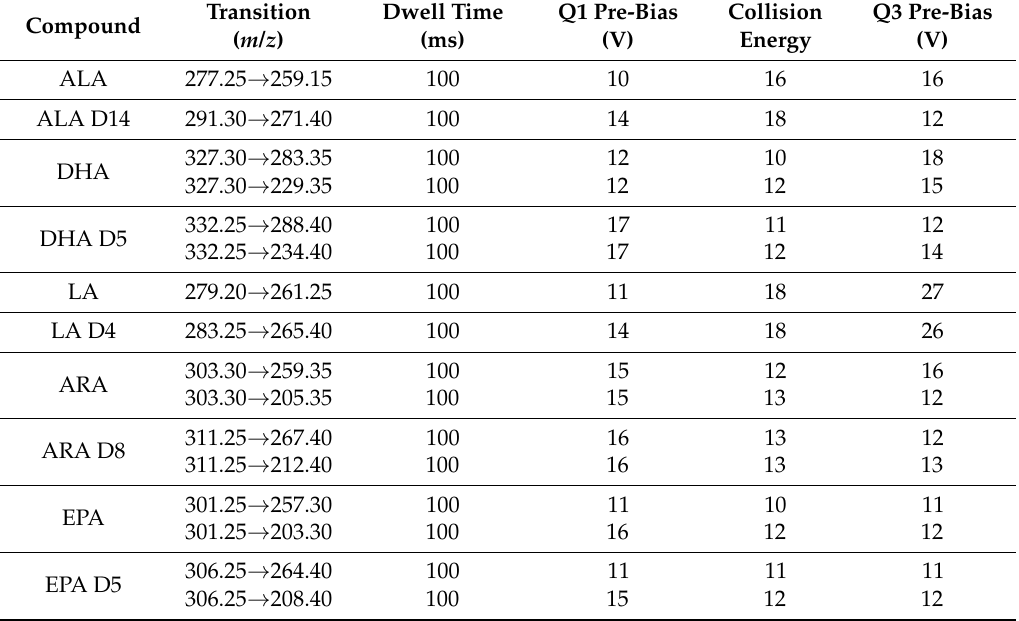
Table 5. Optimized MRM